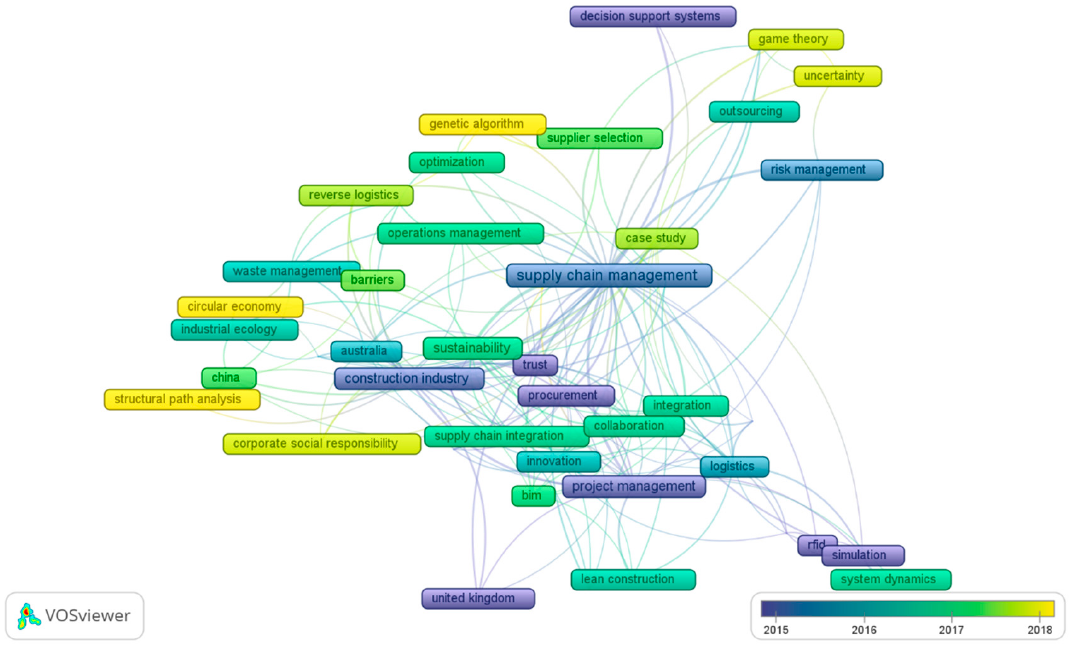
Figure 11 . Co-occurrence network of high-frequency keywords of the CSCM literature . Figure 11. Co-occurrence network of high-frequency keywords of the CSCM